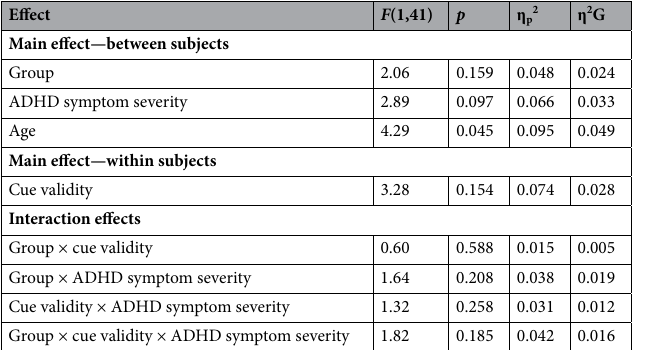
Table 5. The cue validity effect (valid cue vs. invalid cue) and group differences in the cue validity effect on drift rate (v). ADHD: Attention-Deficit/Hyperactivity Disorder.